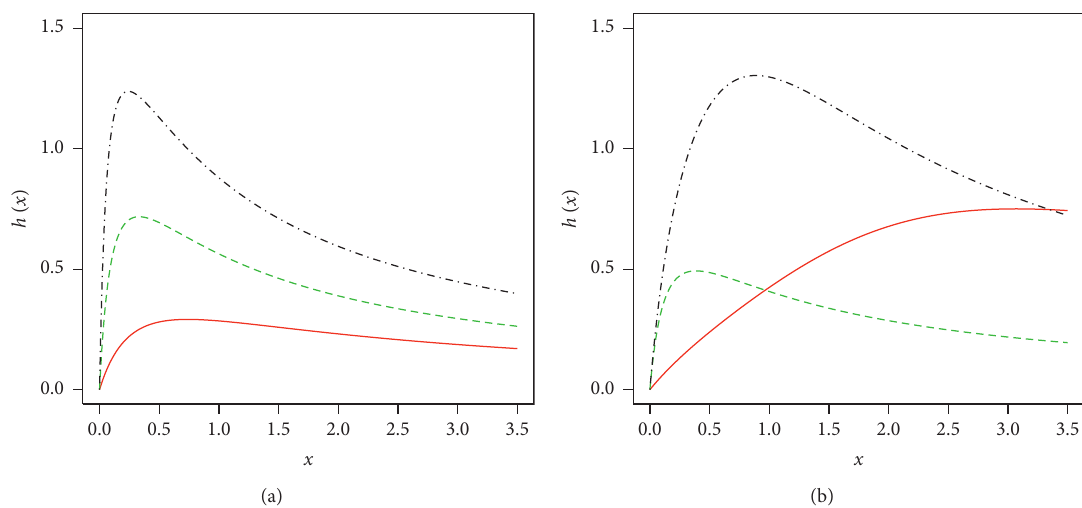
Figure 2: Plots for the hrf of the L-Claim distribution for selected parameter